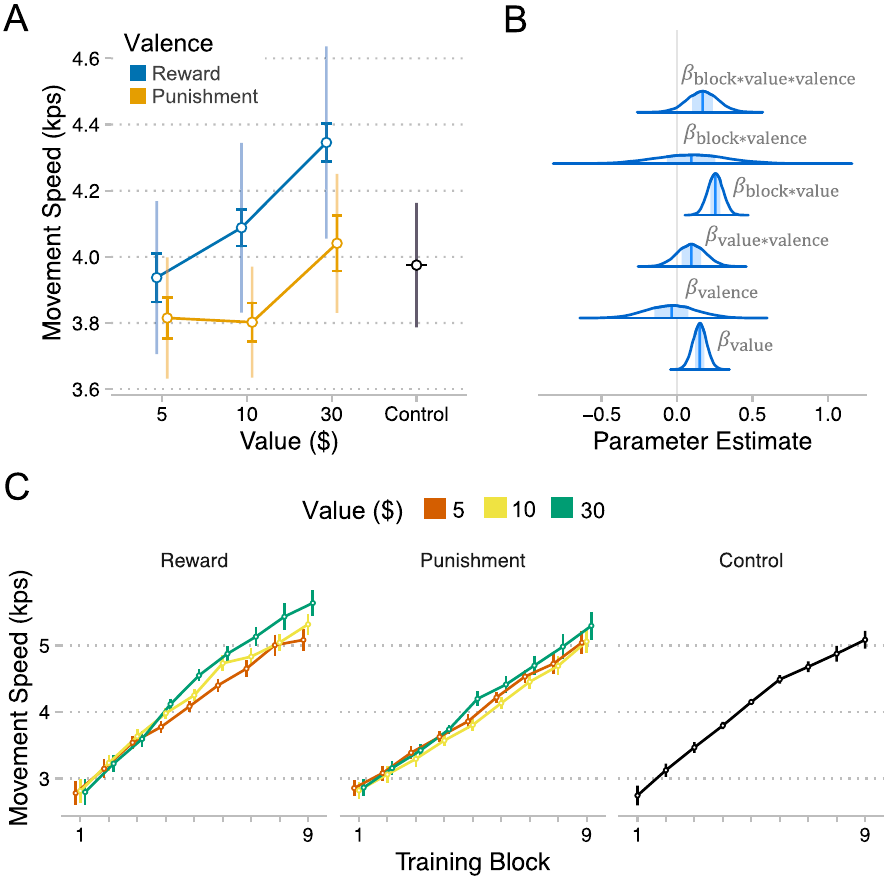
Figure 2. Effects of incentives on the speed of movement execution. ( A ) Speed (mean + /- se) for each level of value by valence. The bold error bars represent within-subject standard error (for value effect) and the non- bold error bars are between-subject standard error (for valence effect). ( B ) Densities of MCMC samples used to approximate posterior probability distributions over key regression coefficients. C. Speed for each level of block by value (sequence) by valence (group). Plots were created using ggplot2 46